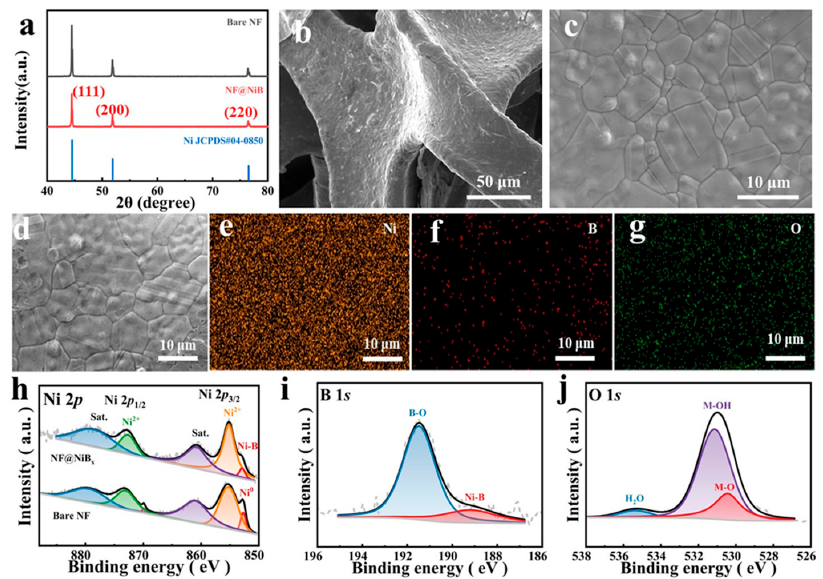
Figure 1. ( a ) XRD pa tt erns of Bare NF and NF@NiB. ( b – c ) SEM images of NF@NiB at low and high magni fi cations. ( d – g ) Elemental mappings for NF@NiB − 3h. The high − resolution XPS spectras Ni 2p ( h ), B1s ( i ), O1s ( j ) of NF@NiB. 2p ( h ), B1s ( i ), O1s ( j ) of